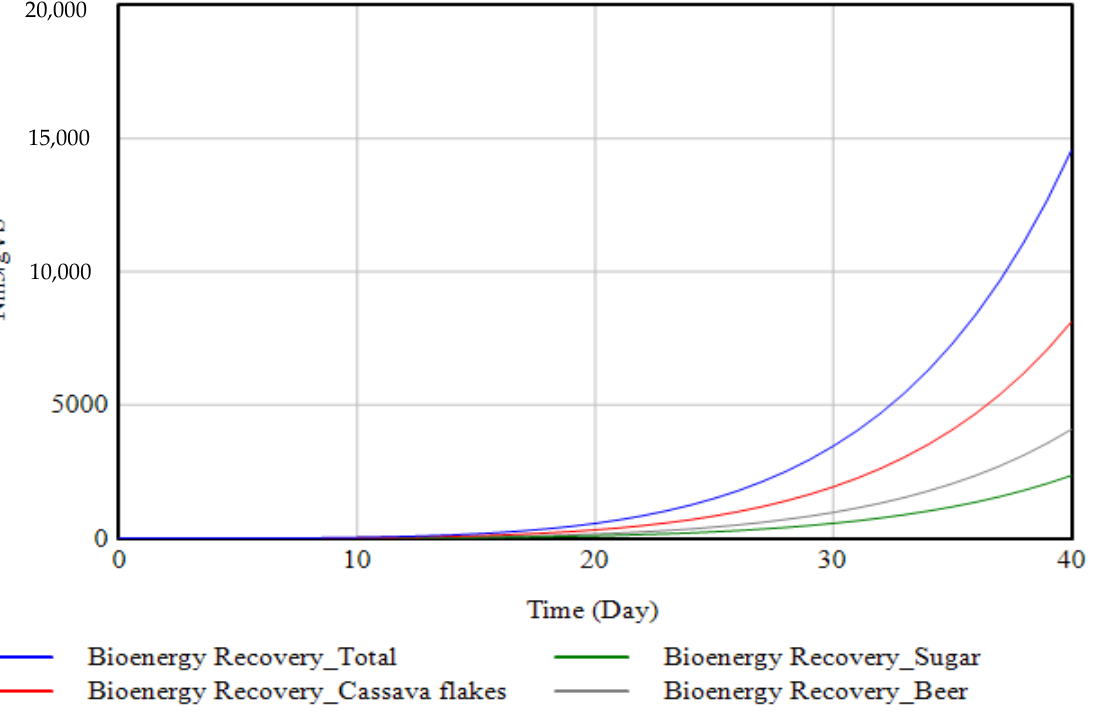
Figure 5. Total estimated biogas produced daily from cassava flakes, sugar, and beer processes.